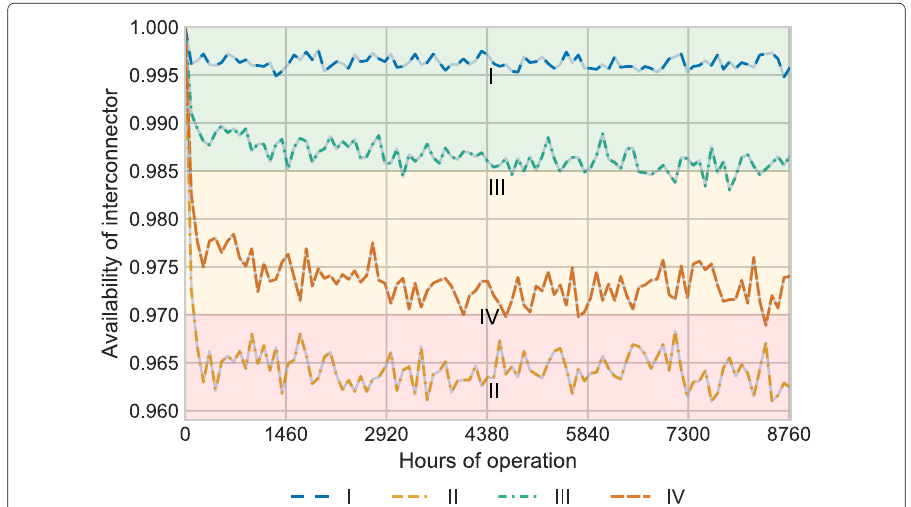
Fig. 9 Probability of failure of redispatch process and the chosen state change thresholds at 0.985 and